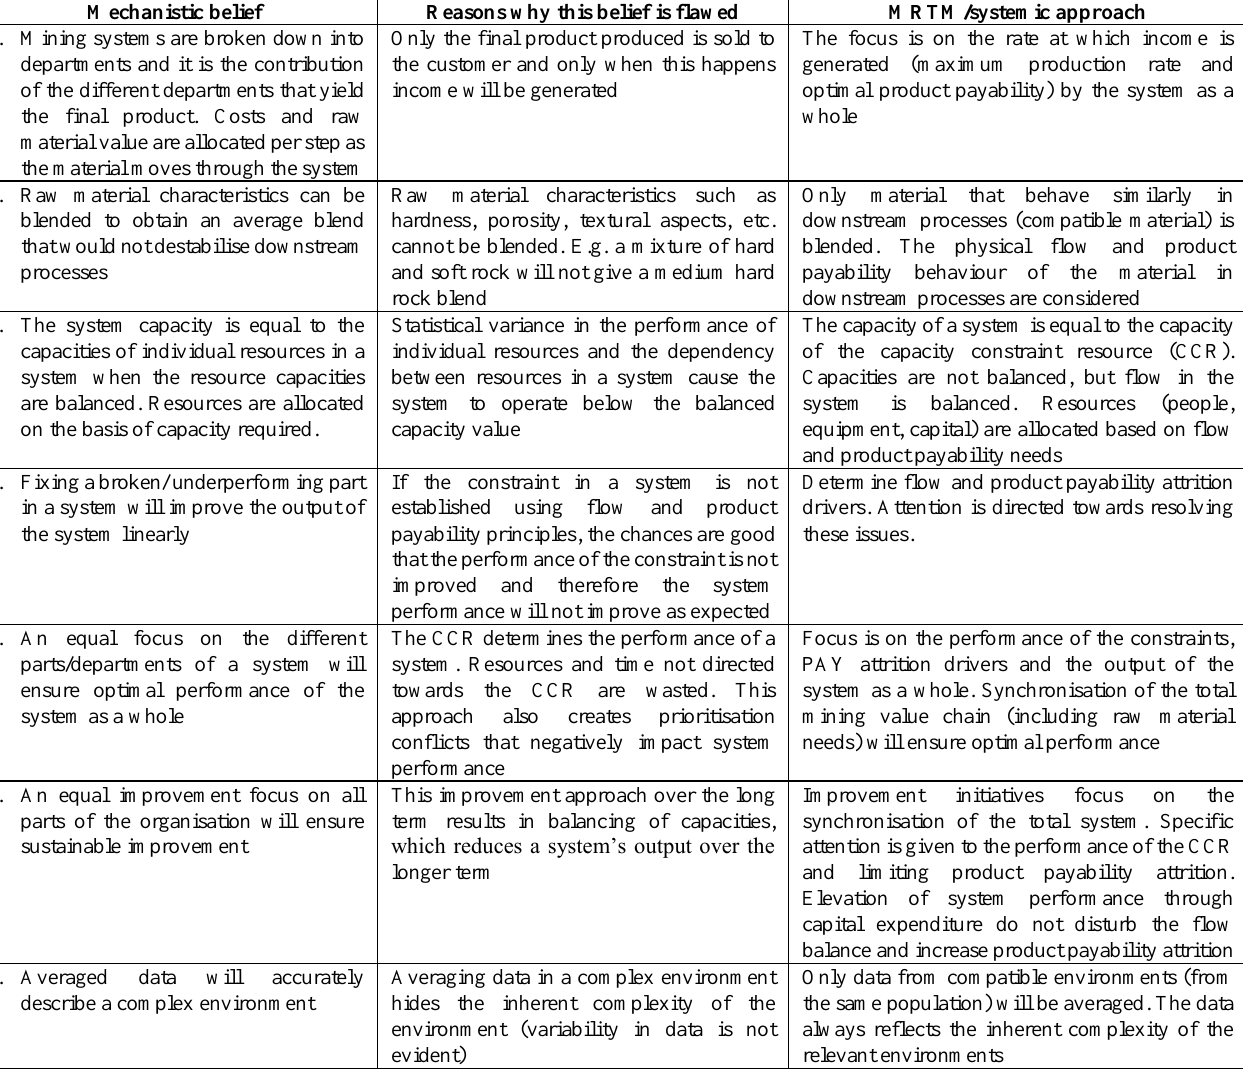
Table 1: Beliefs associated with mechanistic and systemic mindsets in mining Mechanistic